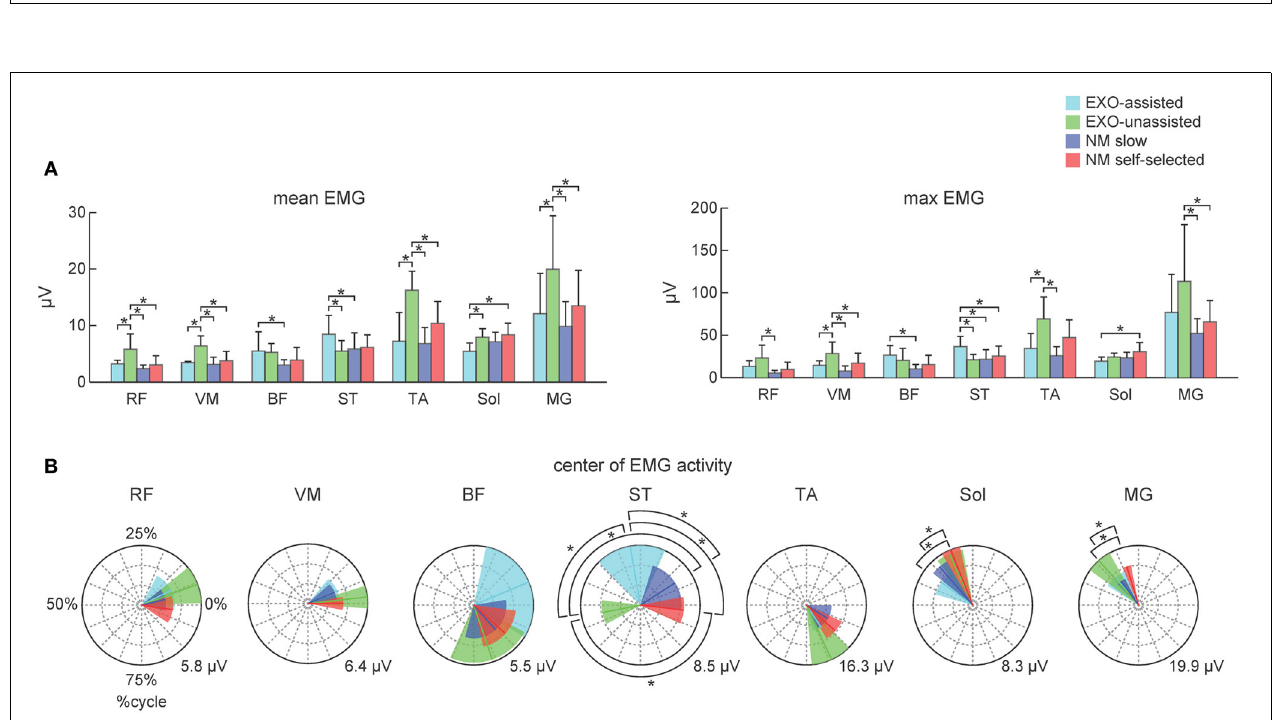
Time course of ensemble-averaged EMG patterns (dark area, gray area corresponds to SD ). Asterisks denote significant differences across conditions.